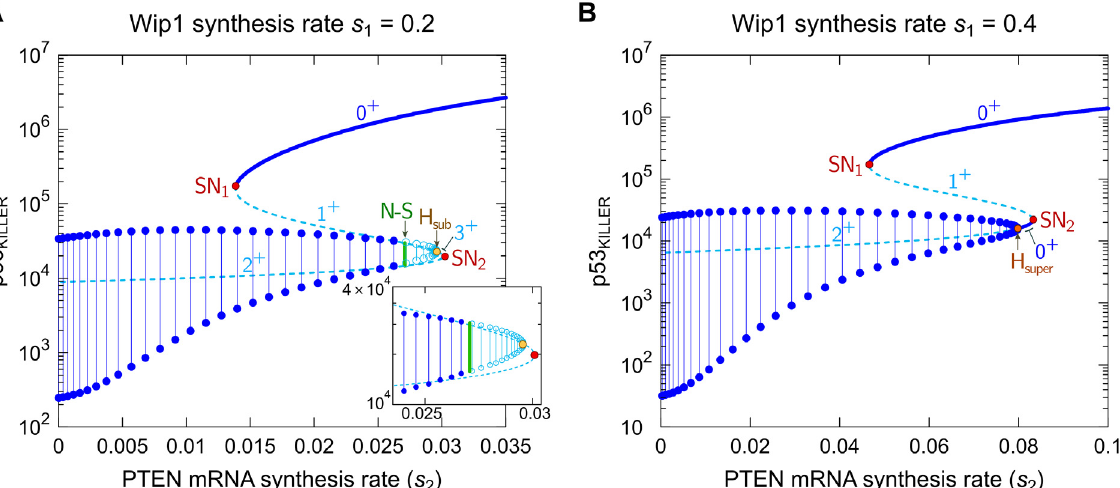
Fig 5. Bifurcation diagram of p53 KILLER vs. PTEN mRNA synthesis rate ( s 2 ). (A) Wip1 synthesis rate s 1 = 0.2, (B) s 1 = 0.4. The stable and unstable steady states are indicated by solid and dashed lines, respectively. Ranges of stable and unstable limit cycles are indicated by dark and light blue lines, respectively; dots and open circles are the maxima and minima of the stable and unstable limit cycles, respectively. Green vertical line in (A) shows Neimark — Sacker bifurcation (N — S). Red dots mark saddle-node bifurcations (SN 1 , SN 2 ), orange dots mark supercritical Hopf (H super ) and subcritical Hopf (H sub ) bifurcations. The numbers in format n + adjacent to the steady state lines denote the number of eigenvalues with the positive real parts. Notice the logarithmic scale on vertical axes.